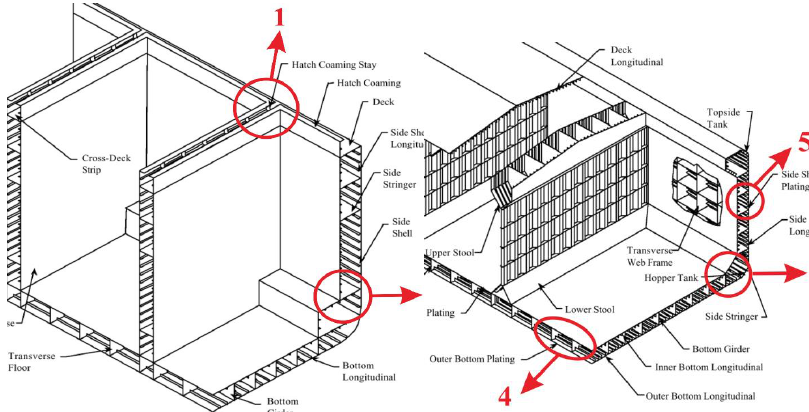
Figure 4. Geometry Locations on Midship Section Model Figure 4: Geometry locations on midship section model [27]